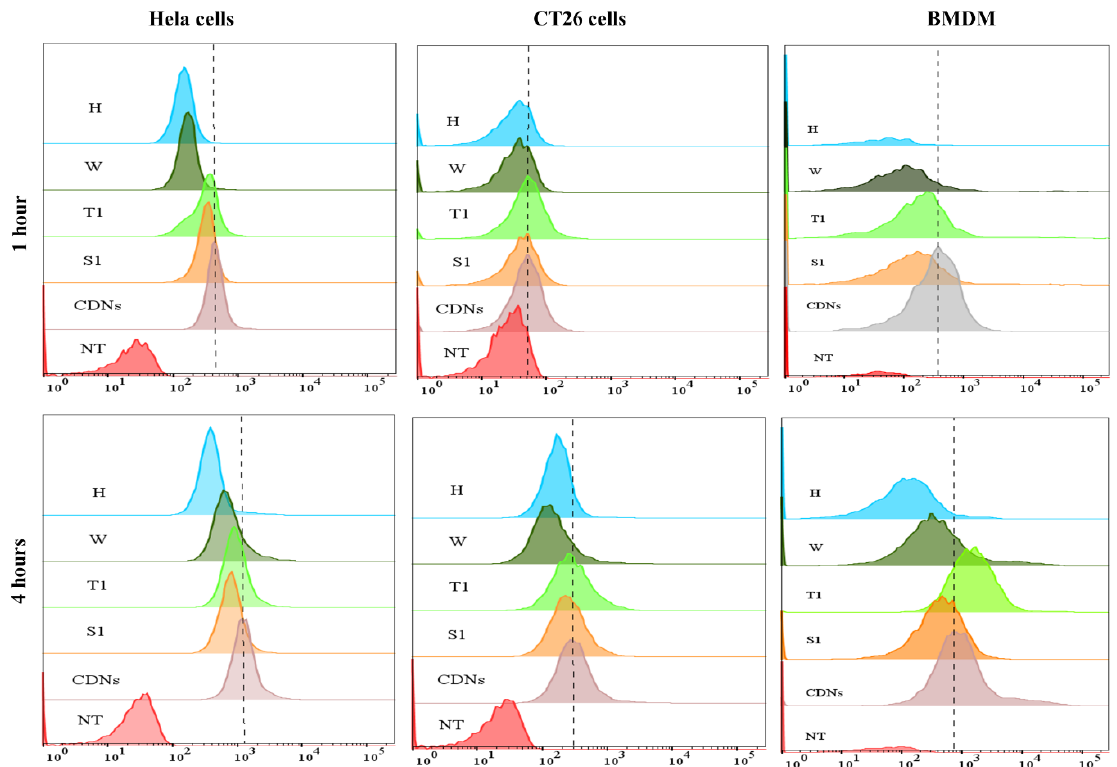
Figure 3. Cellular association of CDNs. Cy3-labeled samples were incubated with HeLa cells, CT26 cells or BMDM for 1 h or 4 h, and then analyzed by flow cytometry and compared between freshly prepared CDNs, sucrose-lyoprotected CDNs (S1), trehalose-lyoprotected CDNs (T1), non-lyoprotected CDNs (W), and heat-denatured CDNs (H). X -axis represents log fluorescence intensity of Cy3, and Y -axis represents counts, NT = non-treated cells (images are representations from three independent experiments).